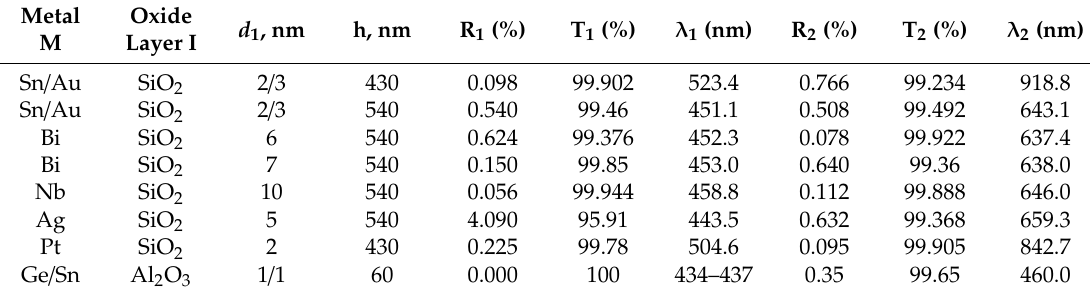
Figure 5. ( a ) The reflectivity wavelength dependence of the Pt nano-film triple layer systems. The Pt nano-film thicknesses correspond to 0 nm (blue), 2 nm (orange) and 5 nm (green). The light wavelength λ is given in µm. The solid curves are the results of the theoretical models based on a transfer matrix method. The 100% anti-reflection and transmission limit is reached in the 2 nm Pt nano-films with a minimum reflectivity value of 0.09% around 0.85 µm. ( b ) The effective complex refractive index calculated at normal incidence for Pt triple layers at different Pt thicknesses. The blue, orange and green lines represent Pt films with thicknesses 0, 2 and 5 nm respectively. The solid and dashed lines are n eff and k eff respectively. Table 2. Experimentally determined parameters of meta-surfaces where perfect impedance matching and 100% anti-reflection has been found. The meta-surfaces were triple layers, consisting of a substrate (Si), an oxide (I) and a metal (M) nano-film layer. Only cases corresponding to transmission greater than 99% and reflectivity less than 1% have been selected. For all samples, the minimal value of the reflectivity R, maximal transmission value T and the associated wavelength λ were recorded. In the case of Ge / Sn films the thickness of the metal Sn film has been carefully tuned to achieve 100% anti-reflection. It should be possible to repeat the same process for other nano-film combinations. All numbers in table are measured in nm and the reflectivity and transmission are given in %. In certain cases combinations of several metal nano-films where tested, and the thickness ratio indicated as